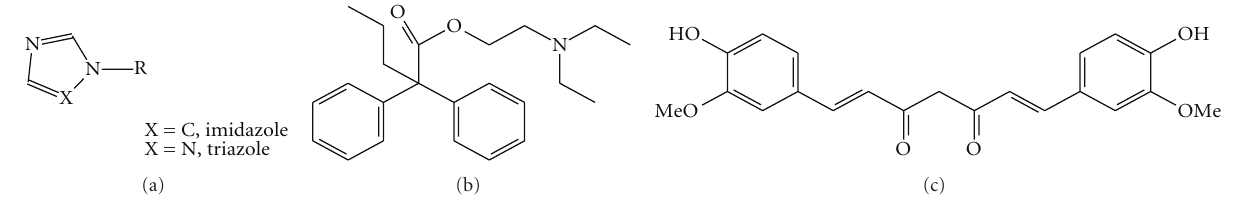
Figure 1: Chemical structures. (a) Azole ring. (b) SFK 525A (Proadifen). (c)